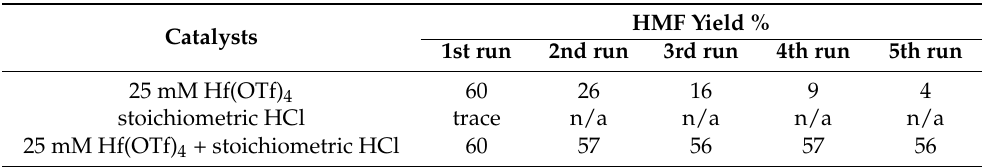
Table 1. The recyclability of 25 mM Hf(OTf) 4 catalyst for glucose dehydration in an aqueous/ sec-butyl phenol biphasic reaction system. Catalysts HMF Yield %